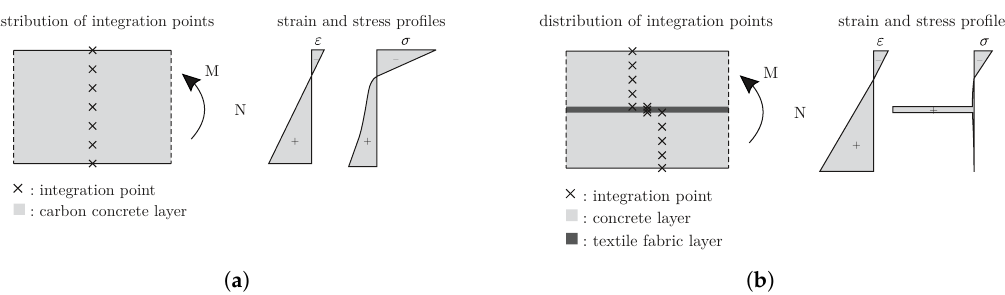
Figure 10. Stress and stress and profiles for the considered representations of the composite cross section with the distributions of integration points over the height: ( a ) smeared idealization with uniform material in each material point; ( b ) resolved cross-sectional idealization with different material behavior in plain concrete and fabric